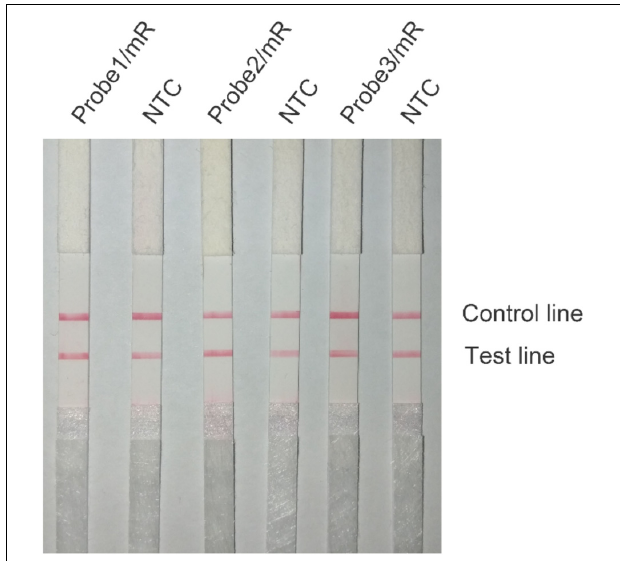
FIGURE 5 | Test of the primer–probe sets on RPA–LFS. The image shows the LFS results of RPA amplifications with different primer–probe sets. The name of each primer–probe set is indicated on the top of each strip. The NTC lanes are the no-template controls of the reactions. The positions of test and control lines are marked on the right of the strip image. The reactions were performed at 40 ◦ C for 30 min.